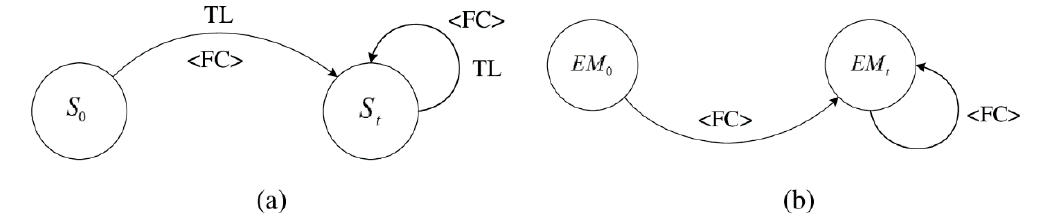
Figure 2. ( a ) Markov model of classifier, and ( b ) Markov model of external memory (EM).